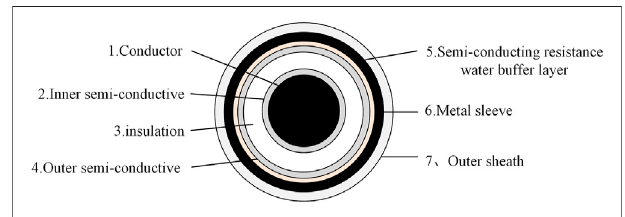
FIGURE 1 | Schematic cross-sectional structure of the body of the 110 kV cable.